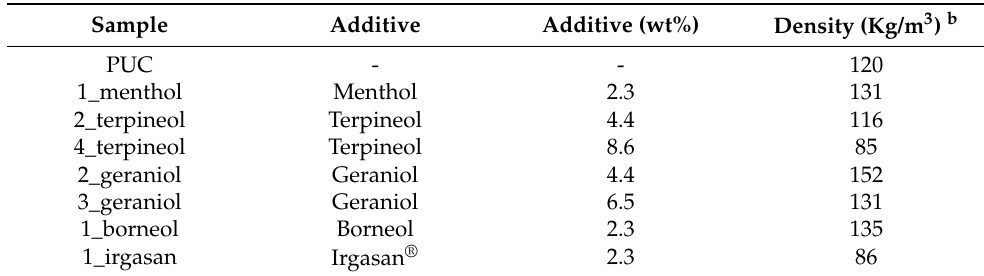
Table 4. Foams with additives used in this study and their core density a .